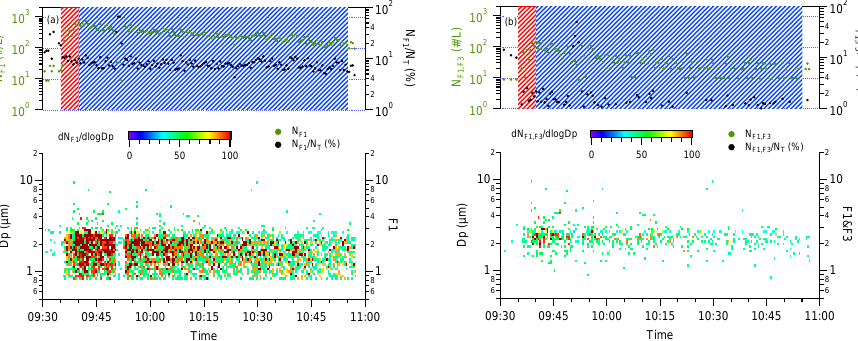
09:30 09:45 10:00 10:15 10:30 10:45 11:00 Time Fig. 4. WIBS-4 fluorescence data for a Saharan dust aerosol experiment conducted during BIO-05. The data are plotted in the same way as in Fig. 3. Red shaded area indicates the addition of Saharan dust aerosol into the chamber, while blue shaded area indicates the integrated sampling